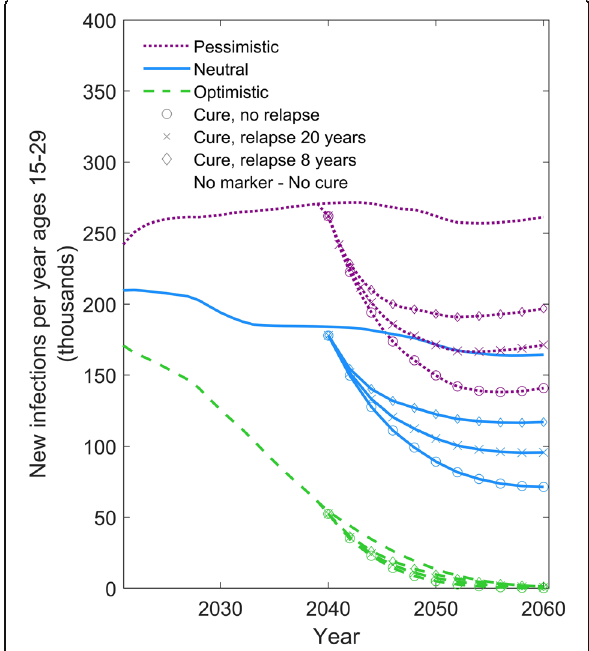
Fig. 4 The effect of the possibility for relapse on the impact of a curative intervention. Comparison between scenarios in which relapse is either not possible or occurs after a mean period of 20years or of 8years. The y-axis shows the number of individuals aged 15 – 29 newly infected with HIV per year. The green dashed, blue solid, and purple dotted lines represent the optimistic, neutral, and pessimistic epidemic forecasts, respectively (see Table 1). The symbols on the line denote the alternative scenarios for the cure